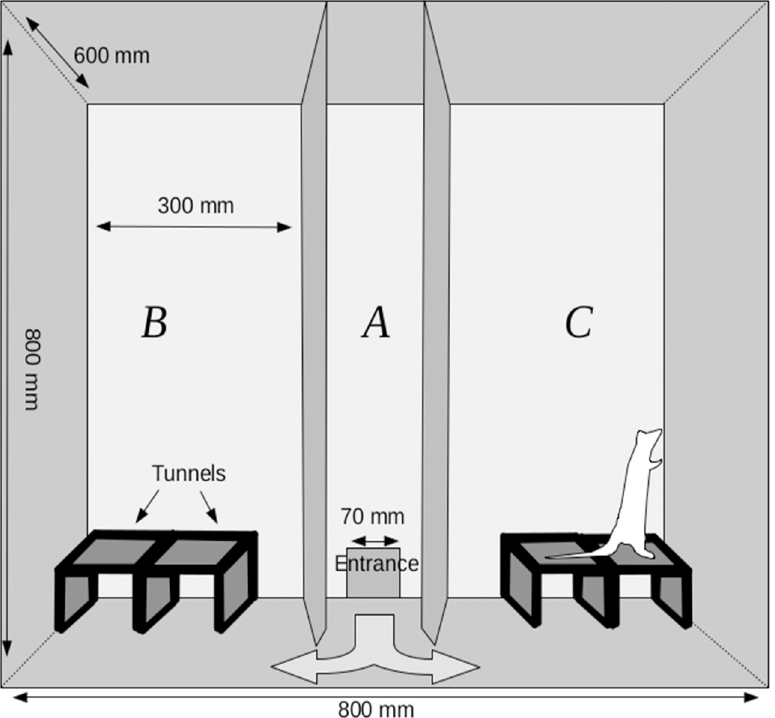
Fig 1. A schematic view of the experimental chamber. A transporter was set up at the entrance. The rat had free access to the transporter at all times. In Zone B the arrangement of the tunnels was the same all the time, in Zone C, on the test days (T1, T2, T3), it was changed depending on the test